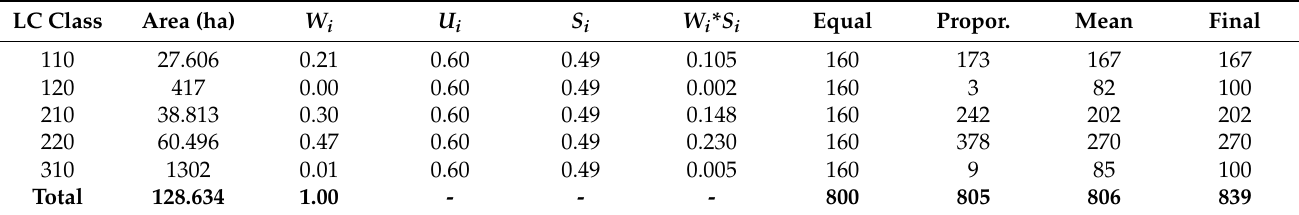
Table A1. Calculation of the sample size of the land cover map of the municipality of Rome from single-date summer image classification.